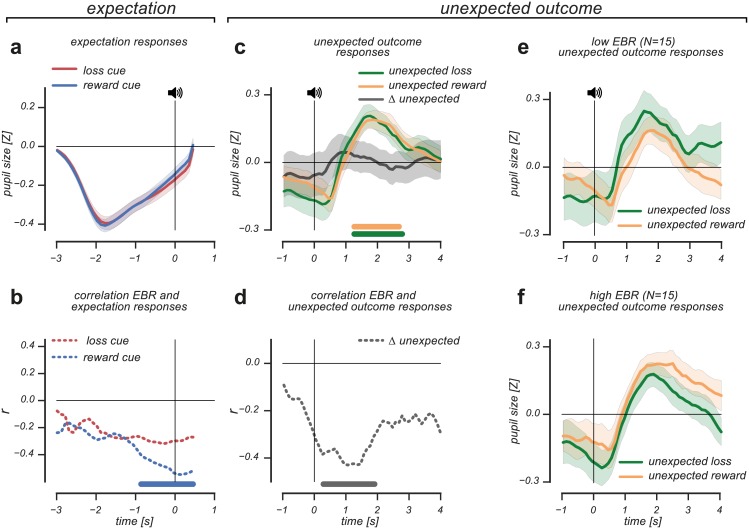
Arousal-based pupil responses during value expectation and outcome evaluation show different correlation patterns with EBR.(A): Reward and loss expectation elicited identical pupil responses. (B): Reward expectation correlated significantly with EBR, indicating that reward expectation elicits stronger pupil dilation in individuals with low compared to high EBR. (C): Violated reward and loss expectations resulted in unsigned, transient pupil dilation. No dilation differences were observed between U- and U+ responses, which was reflected in the ΔU response. (D): ΔU correlated significantly with EBR, indicating that the variability in the ΔU response related to individual differences in EBR (E & F): A median split on individual differences in EBR visualizes the correlation between ΔU and EBR, where pupil dilation response patterns to unpredicted outcomes reversed for individuals with low compared to high EBR. Horizontal significance designators indicate time points where p<0.05. Error bars are standard error of the mean. Statistics based on cluster-based (correlation) permutation tests, n = 1000.